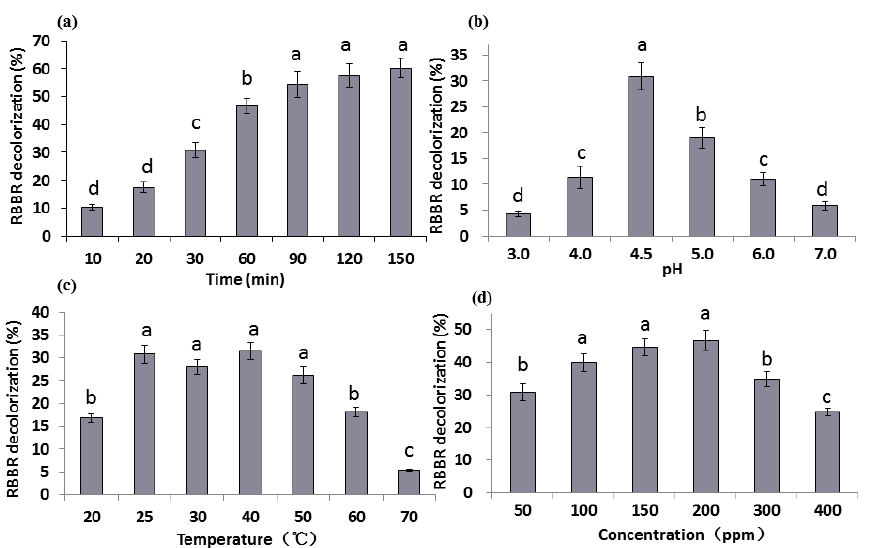
Figure 2. Decolorization percentage of RBBR under di ff erent conditions of: ( a ) time; ( b ) pH; ( c ) temperature; and ( d ) dye concentrations. The final laccase activity of the reaction system was 1000 U L − 1 . Decolorization percentage was determined by measuring changes in absorbance at 592 nm. The error bars represent the standard deviation of triplicate samples. Di ff erent letters (a, b, c, d) above bars indicate statistically significant di ff erences between groups according to one-way ANOVA ( n = 3, p < 0.05; refer in-text for test specifics and test statistics).